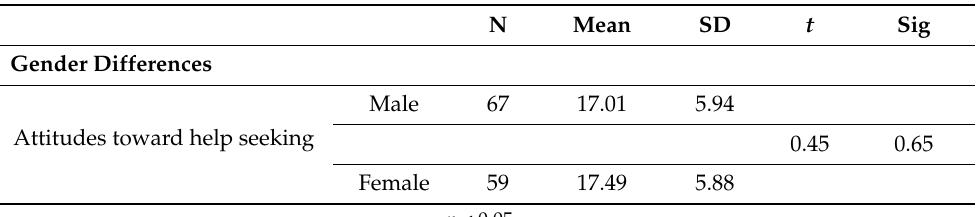
Table 1. t -test for gender differences on attitudes towards help